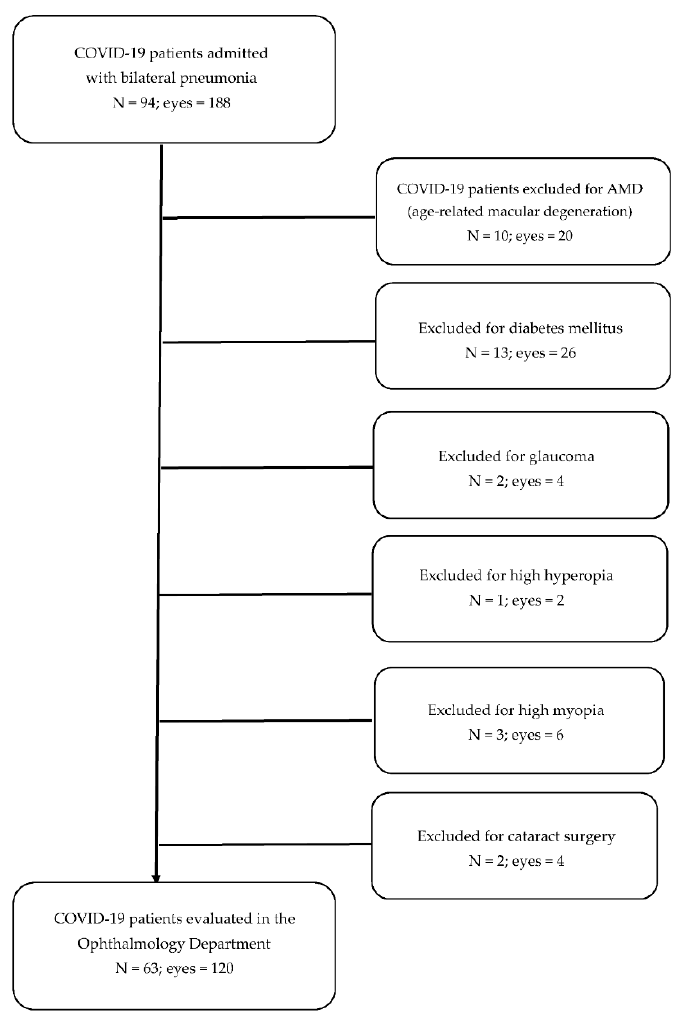
Figure 1. Flowchart of COVID-19 patients included in the study and excluded from the study.